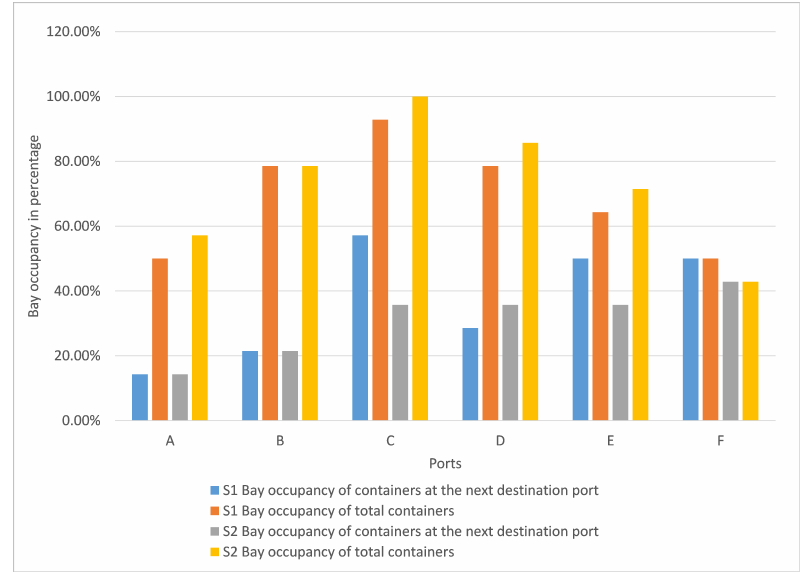
Figure 12. Occupancy in bays of strategy